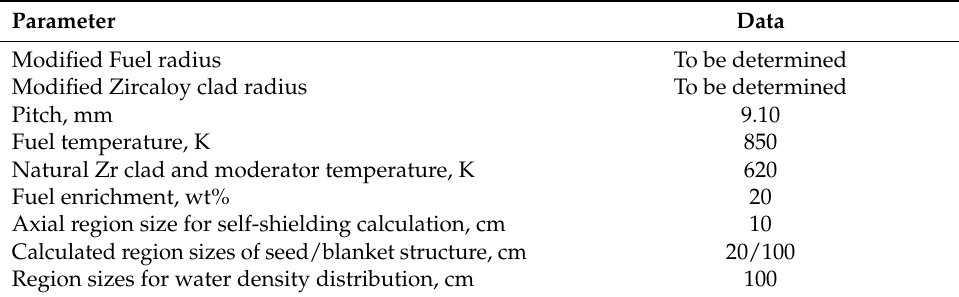
Table 2. RBWR-analogue equivalence axial model